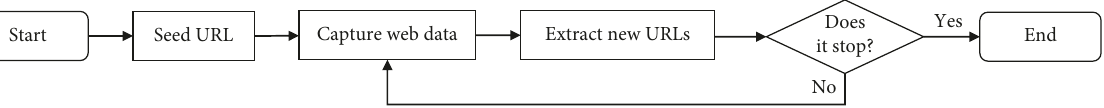
Figure 1: Detailed principle of the web crawler.